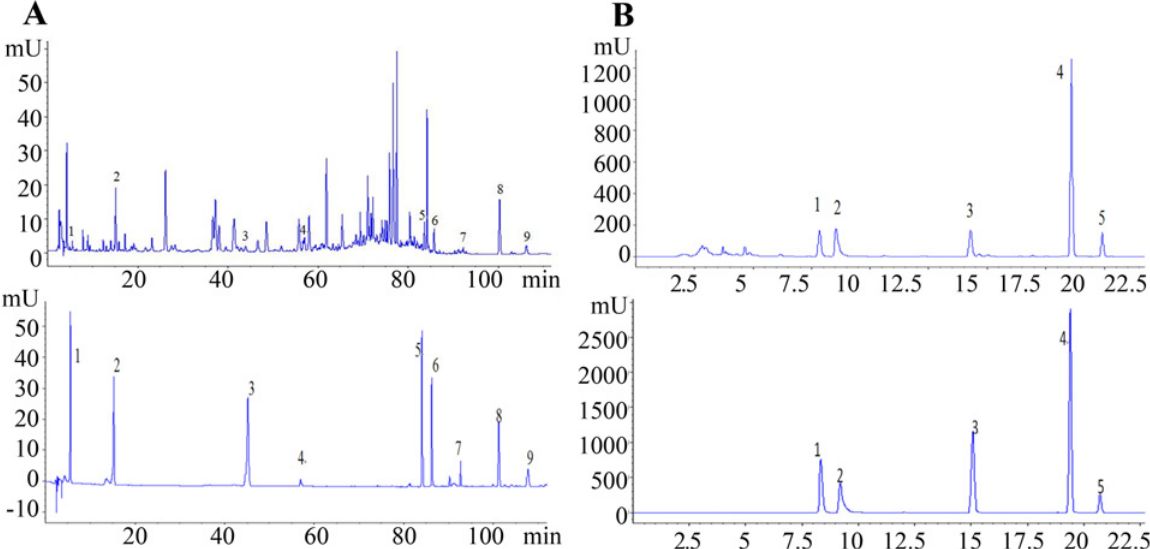
Fig 4. A: Chromatograms of rhubarb and the corresponding reference material of GA (1), CA (2), SB (3), SA (4), AE (5), RH (6), EM (7), CH (8), and PH (9). B: Chromatograms of rhubarb and the corresponding reference material of AE (1), RH (2), EM (3), CH (4), and PH